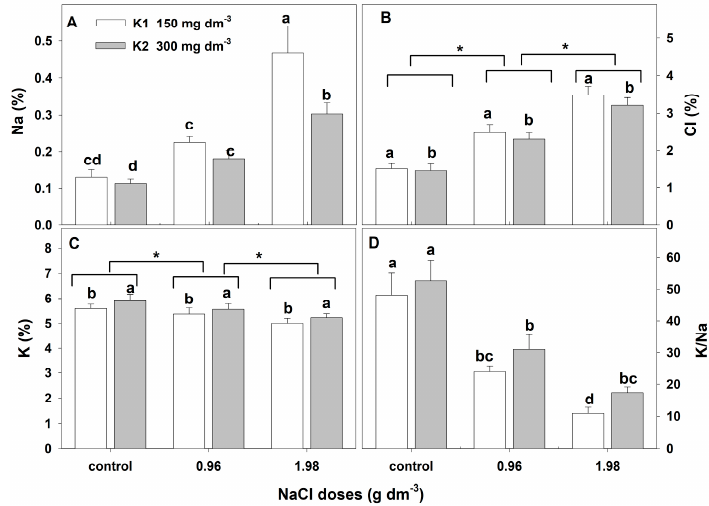
Figure 5. The effect of salinity doses on the concentration (%DM) of Na, Cl, K, and K/Na in the leaves of zinnia grown with two potassium doses. In ( A , D ), different letters show statistically significant differences between combinations; in ( B , C ), letters a and b show a significant effect of K doses, and an asterisk (*) shows a significant effect of salt doses. Values are expressed as the means (n = 6) ± standard deviation.